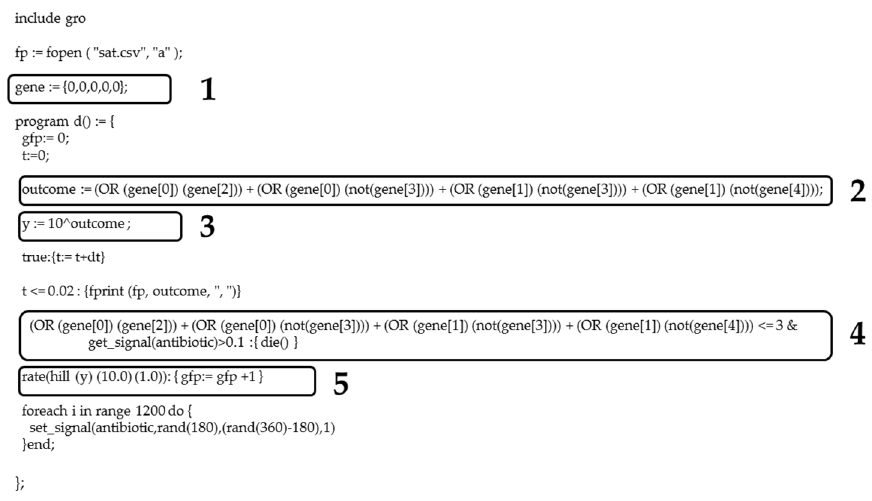
Figure A6. SAT problem implemented in Gro language. ( 1 ) List ( gene ) of which elements are the variables included in the Boolean expression, initializing the list as {0, 0, 0, 0, 0}. ( 2 ) Boolean expression for a 2-SAT problem. ( 3 ) Calculation of y = ( outcome ). ( 4 ) Conditional sentence of the antibiotic resistance. ( 5 ) Hill function models the GFP reporter protein synthesis as a function of y value, and therefore, the number of satisfied clauses. In the output of the routine in Gro, i.e., evaluation table, the gene value is the number of variables that satisfy the Boolean expression ( 2 ), while the total amount of GFP or fitness is given by stats.num*stats.average .